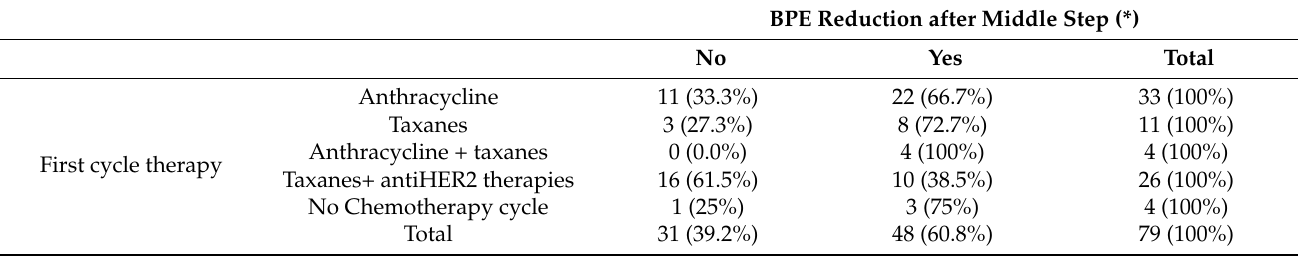
Table 6. Distribution of BPE reduction compared to the type of the first cycle of